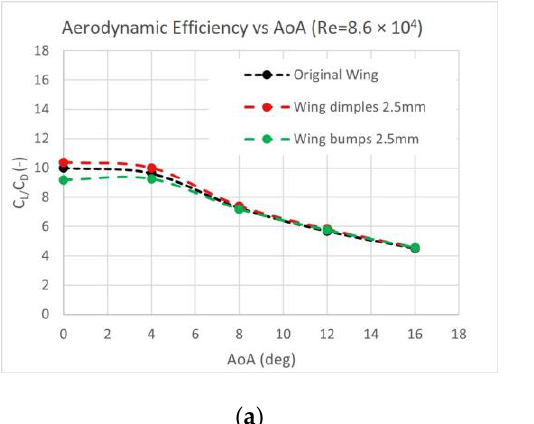
Figure 10. Drag coefficient of the three wings under ( a ) Re = 86,000 and ( b ) Re = 258,000.